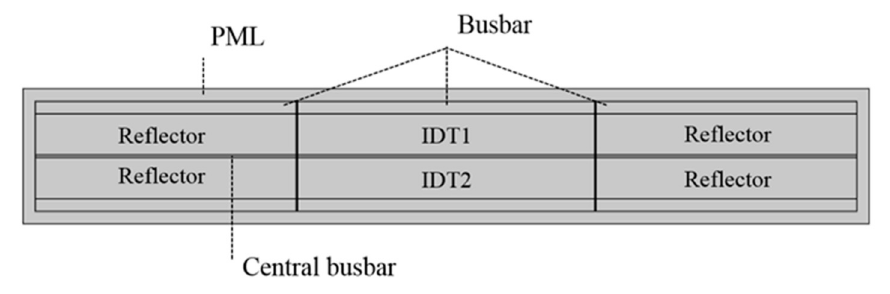
Figure 4. Geometric model of TC-SAWR constructed in COMSOL. Table 3. The substrate material and structural parameters of